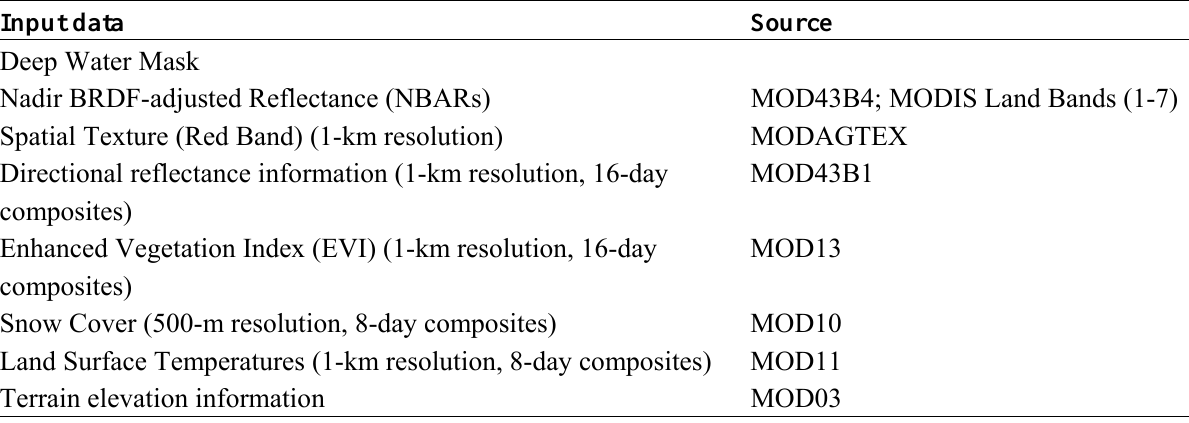
Table 1. Input datasets used in land cover classification algorithm developed for the MOD12Q1 Product